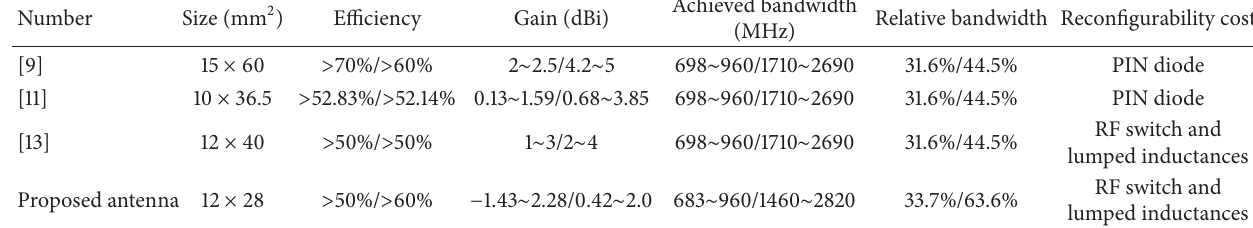
Table 1: Size and performance of previously reported antennas and the proposed antenna.